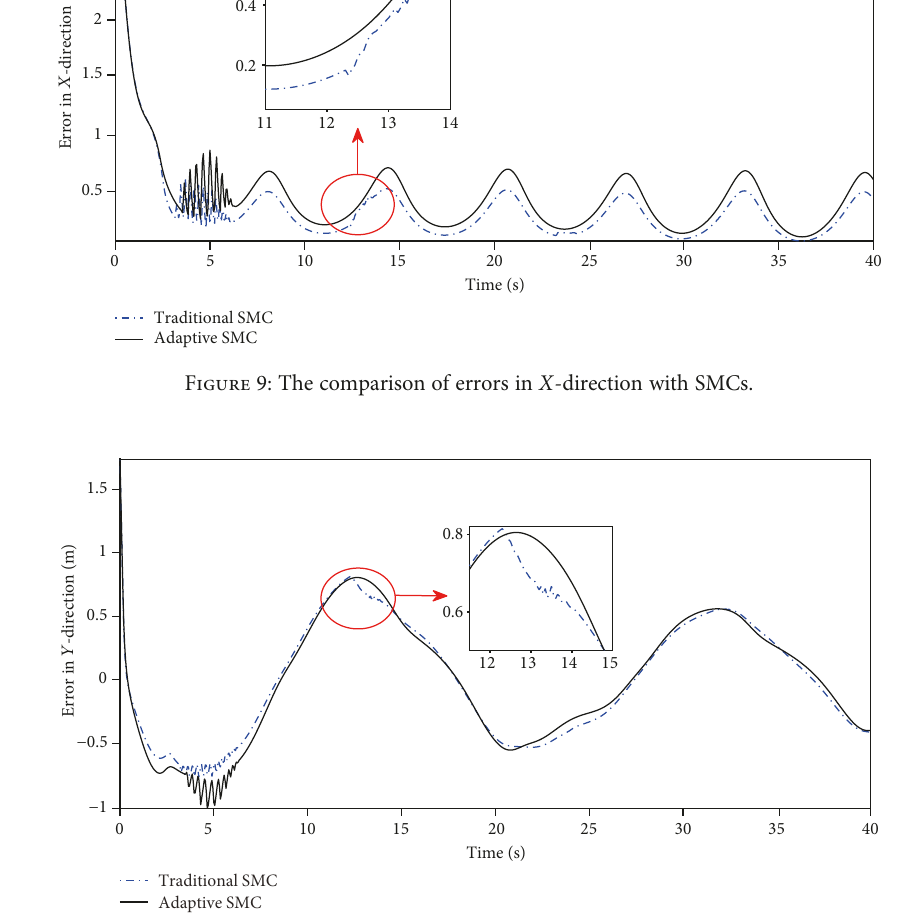
Figure 10: The comparison of errors in Y -direction with